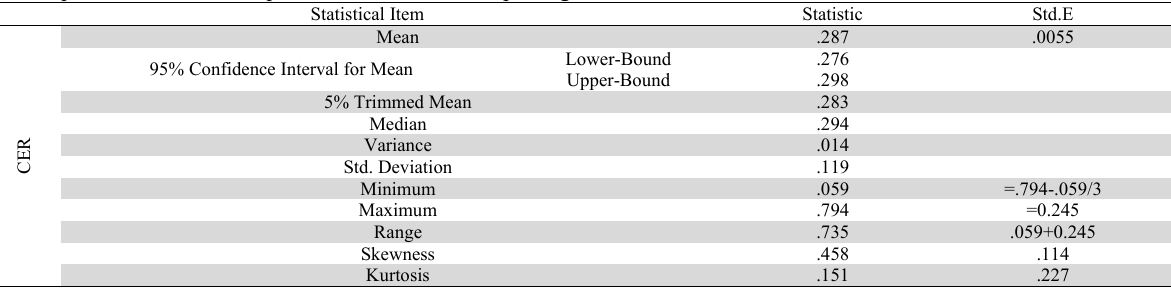
Descriptive Statistics of Corporate Environmental Reporting Statistical Item